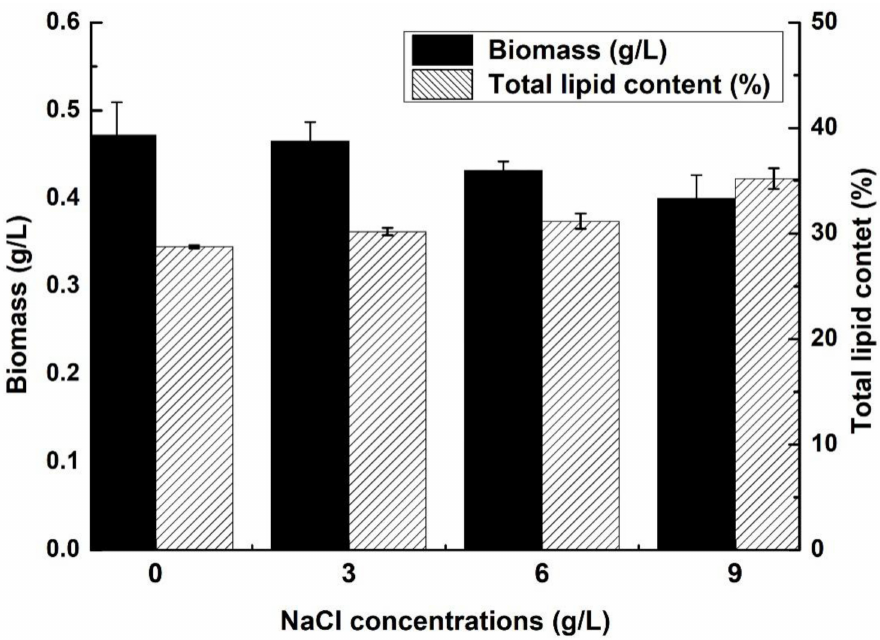
Figure 1. Effects of different NaCl concentrations on cell biomass and total lipid